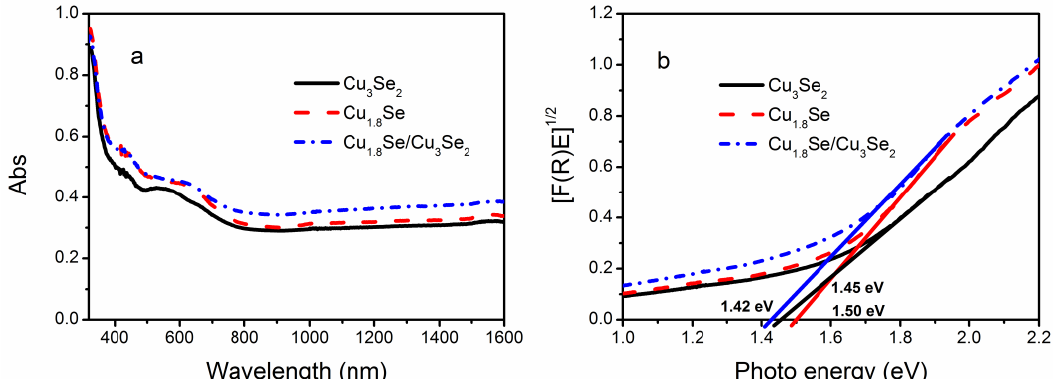
Figure 3. ( a ) UV-visible-near-infrared (UV-Vis-NIR) diffuse reflectance absorption (DRS) spectrum of copper selenides; ( b ) A plot transformed according to the Kubelka–Munk function versus energy of light.